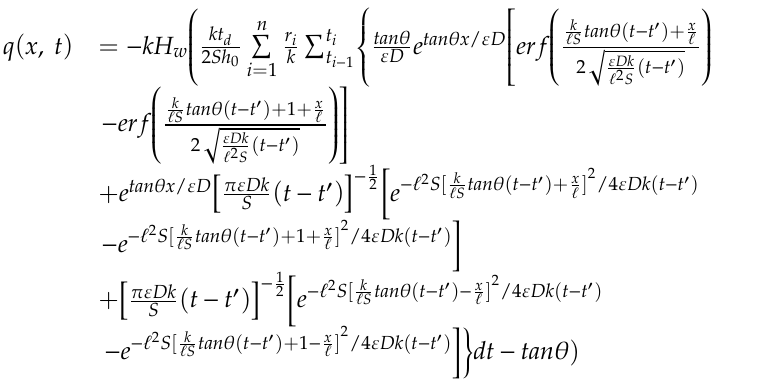
parameters were used: ε = 1/3, recharge length (cid:96) = 100 m, soil layer thickness D = 7 m,